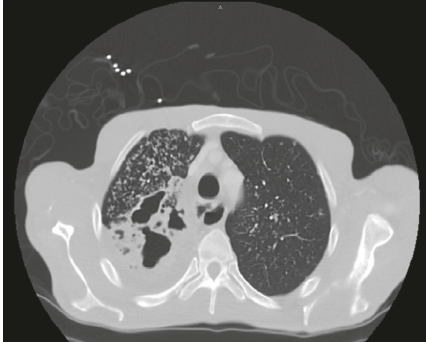
Figure 2: Contrast-enhanced CT scan. Axial section (neck) showing airspace consolidations with diffuse tree in bud opacities in the right lung apex and to a less extent, in the left lung apex. In addition, there are multiple areas of cavities within the right lung apex.